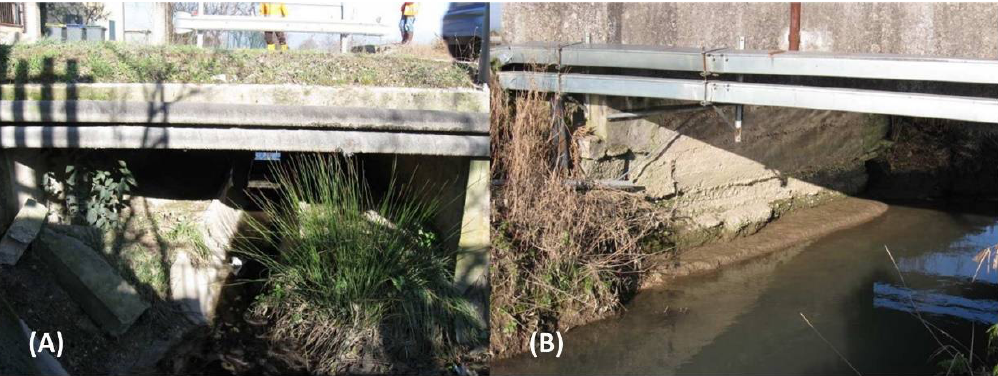
Figure 9. Degree of vulnerability of the bridge on secondary hydrographic network ( A ) and road embankment ( B ).